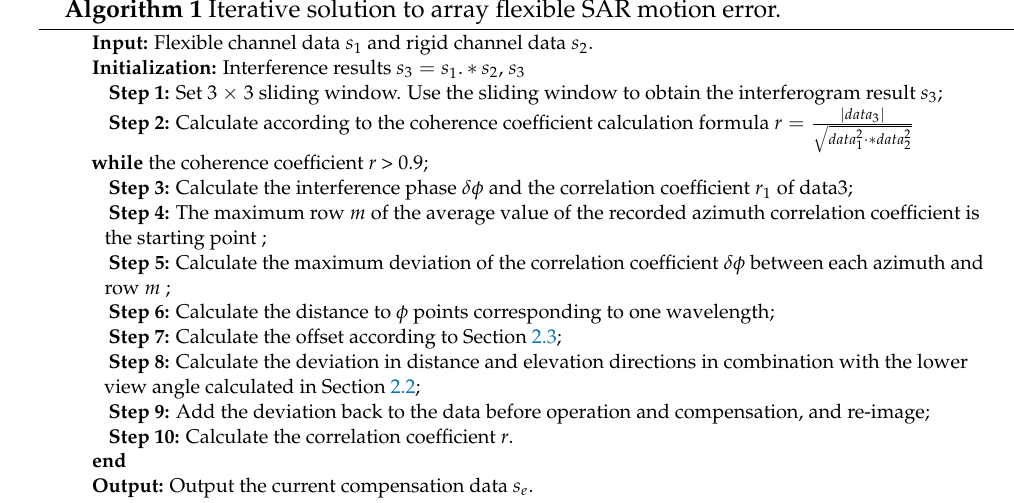
Algorithm 1 Iterative solution to array flexible SAR motion